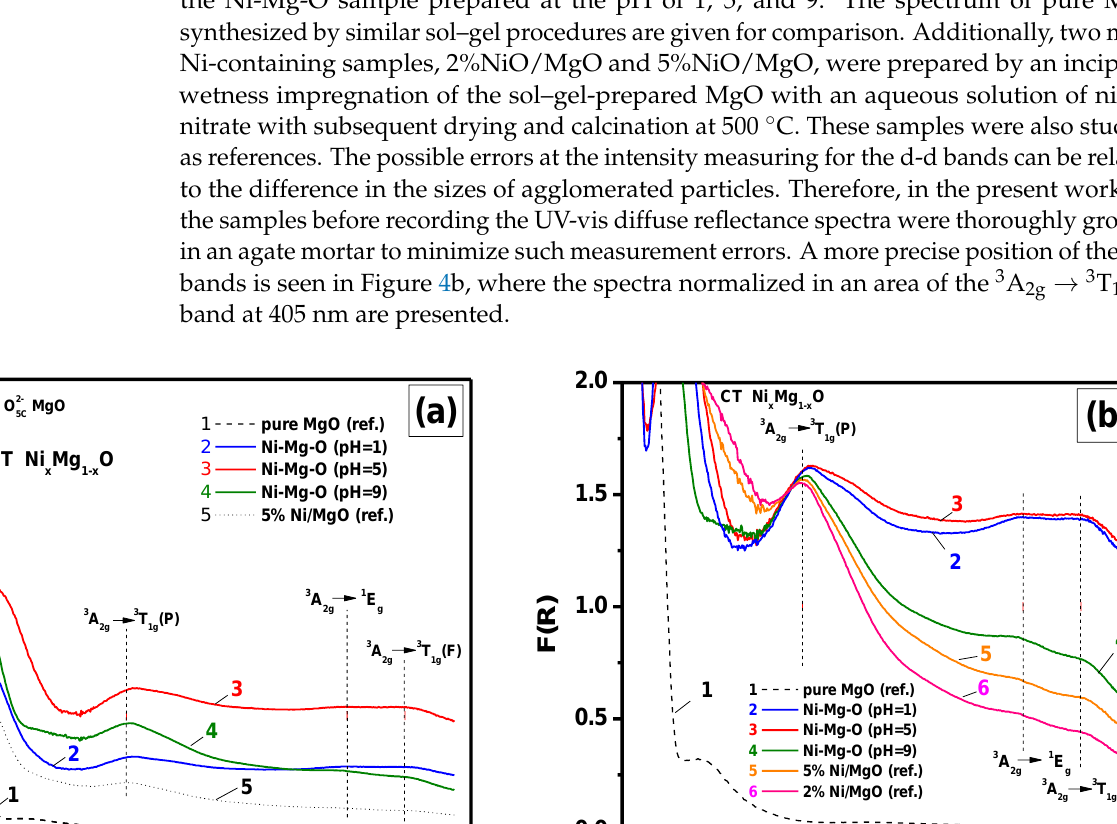
Figure 3. XRD patterns of the Ni-Mg-O samples obtained at various pH. Table 2. The lattice parameters ( a ) and estimated crystallite size (D) of the studied samples and NiO and MgO standards.